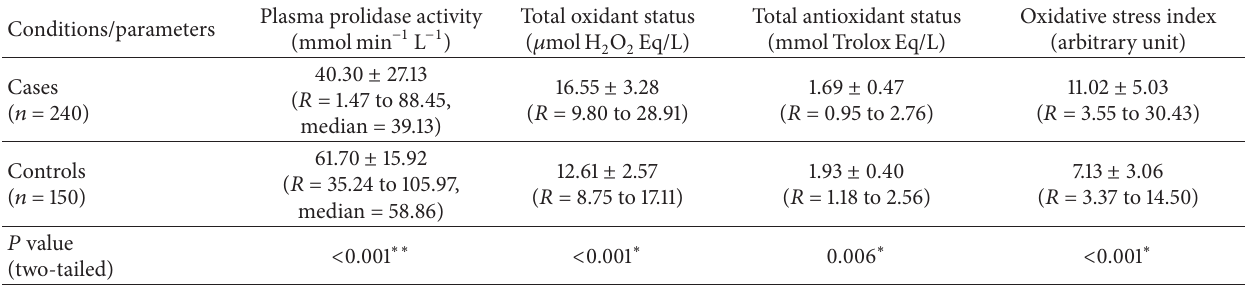
Table 1: Representation of plasma prolidase activity, total oxidant status, total antioxidant status, and oxidative stress index in cases and